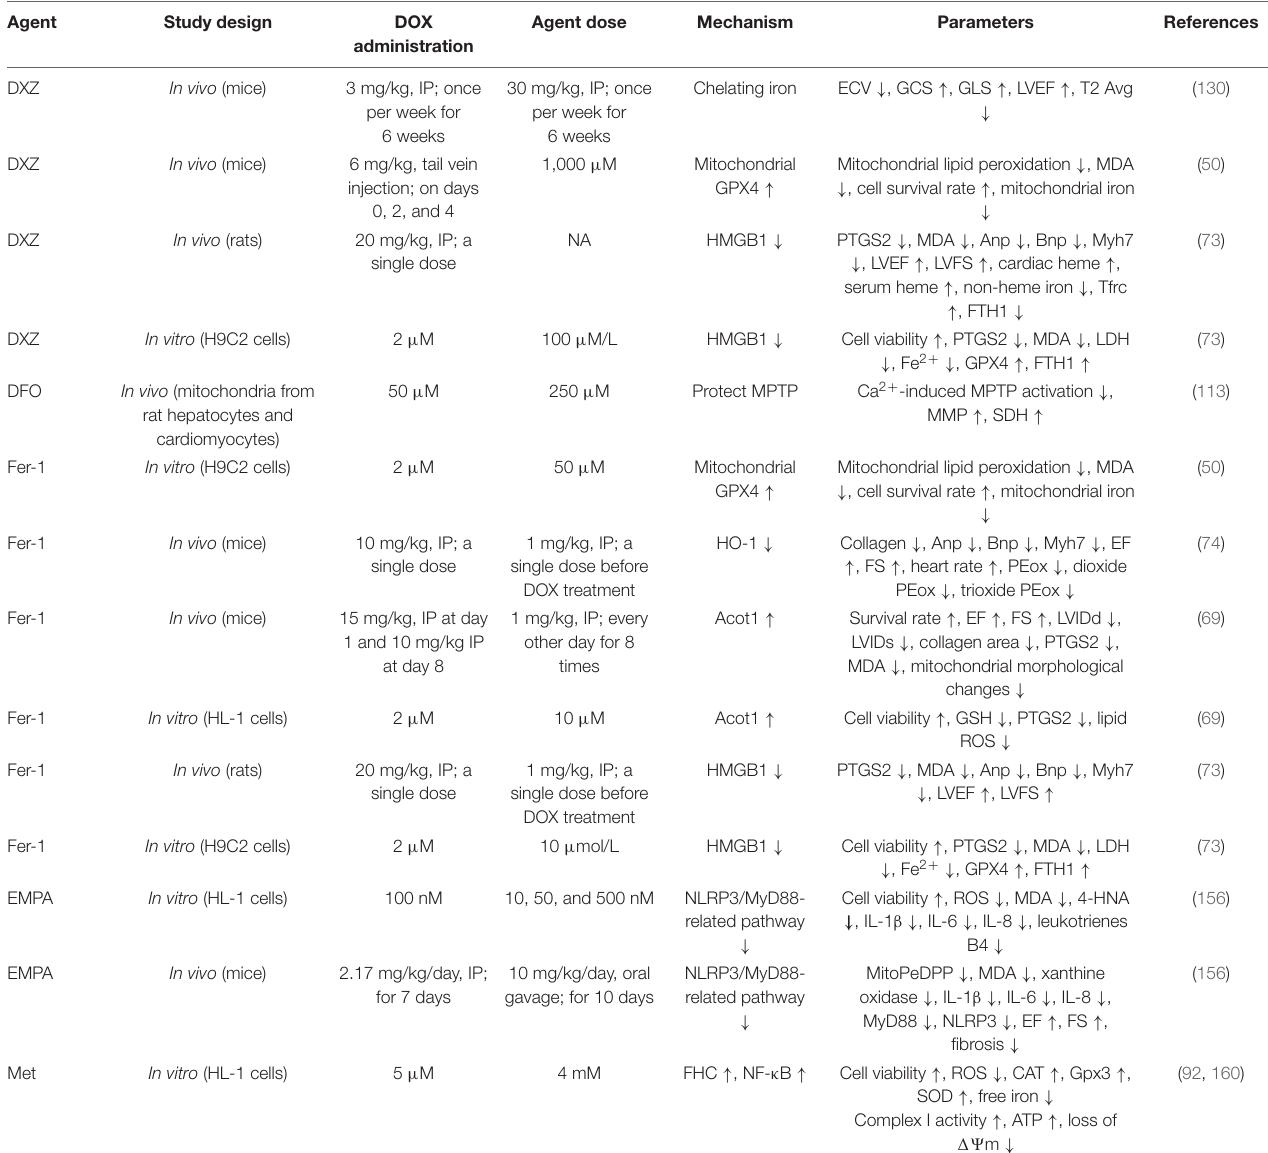
TABLE 2 | The therapeutic strategies against ferroptosis in